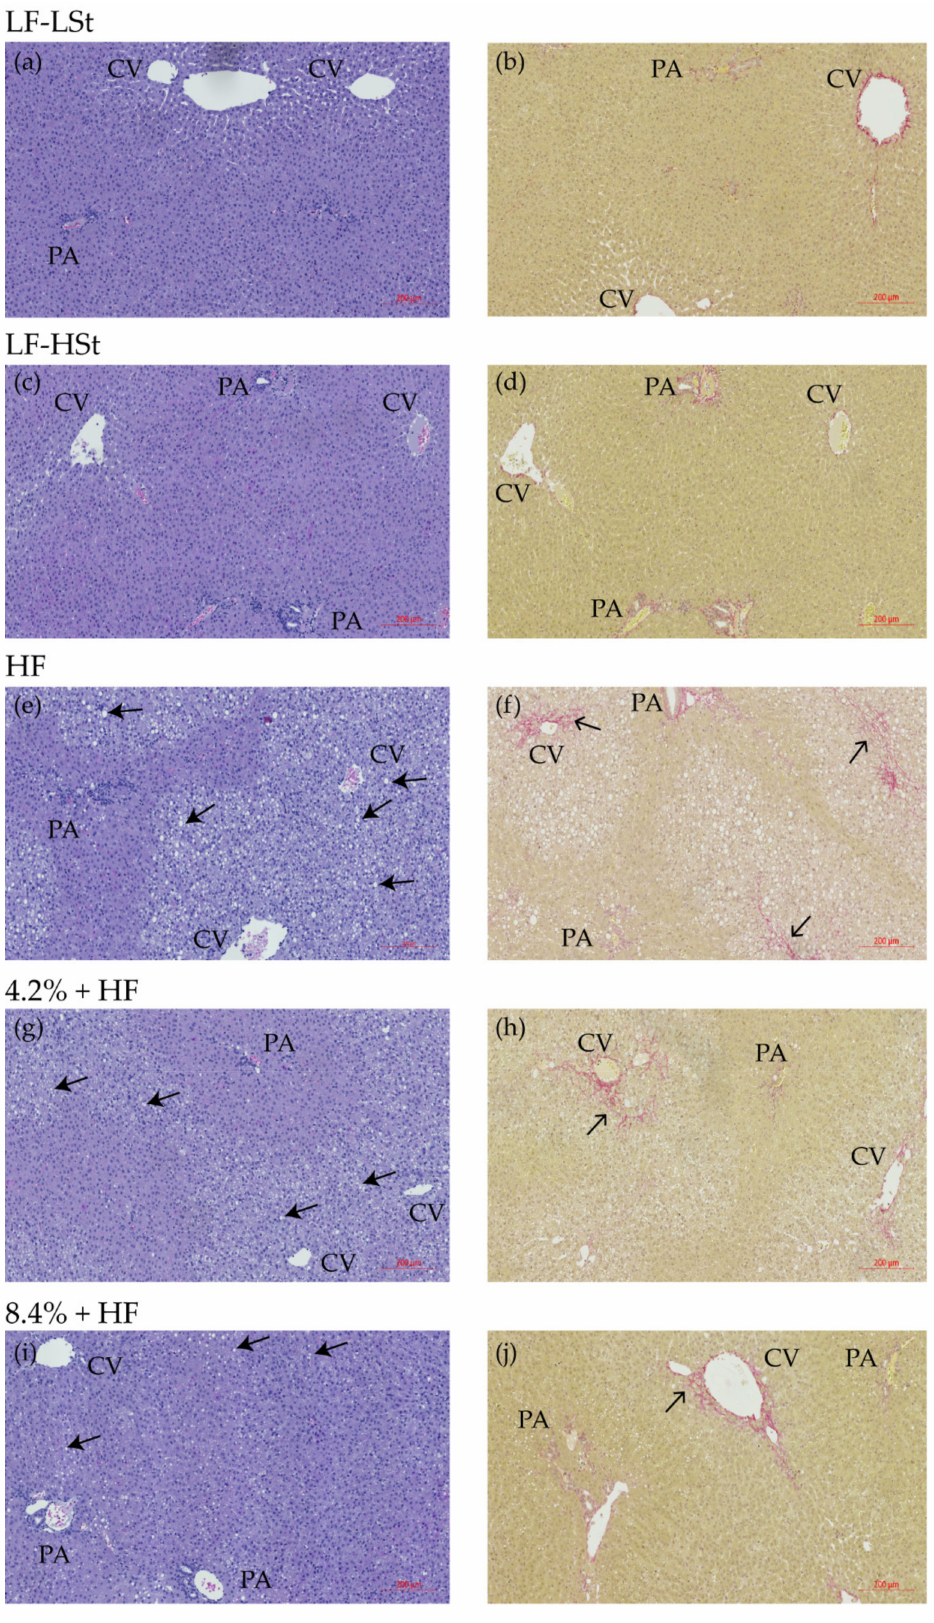
Figure 4. Representative histological images. ( a , c , e , g , i ) Hematoxylin and eosin stain. Scale bar shows 200 µ m. ( b , d , f , h , j ) Picro Sirius Red stain. Scale bar shows 200 µ m. Solid arrows indicate lipid vacuoles, and open arrows indicate fibrosis (in red). CV: central vein, PA: portal area, HF: high fat, LF: low fat, HSt: high starch, LSt: low